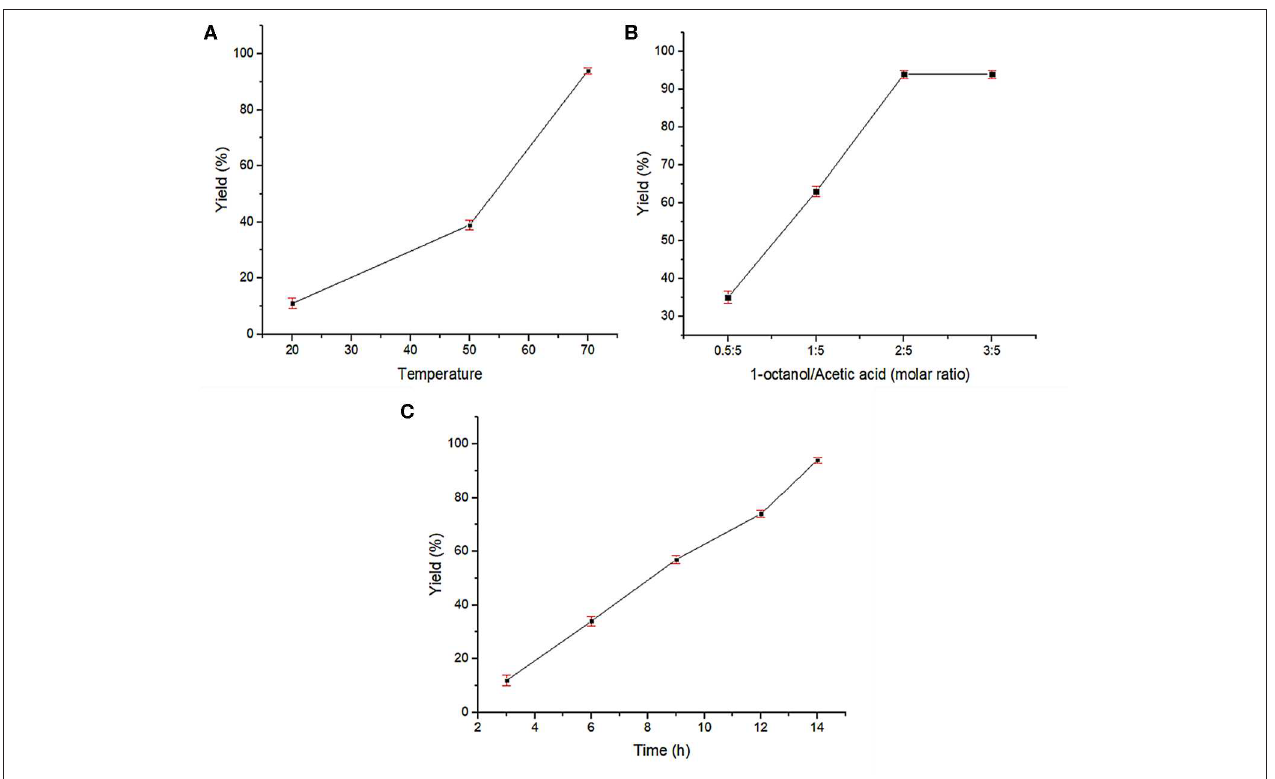
FIGURE 8 | Effects of reaction parameters in the esterification of acetic acid by 1-octanol: (A) reaction temperature, (B) molar ratio of 1-octanol to acetic acid, and (C) reaction time.